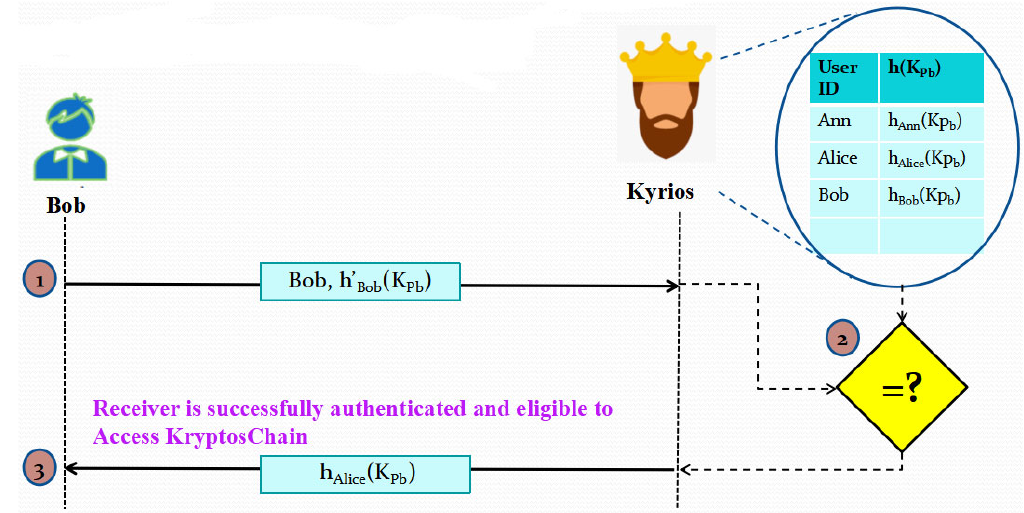
Figure 5. Illustration of Phase 4: Receiver Authentication Process.